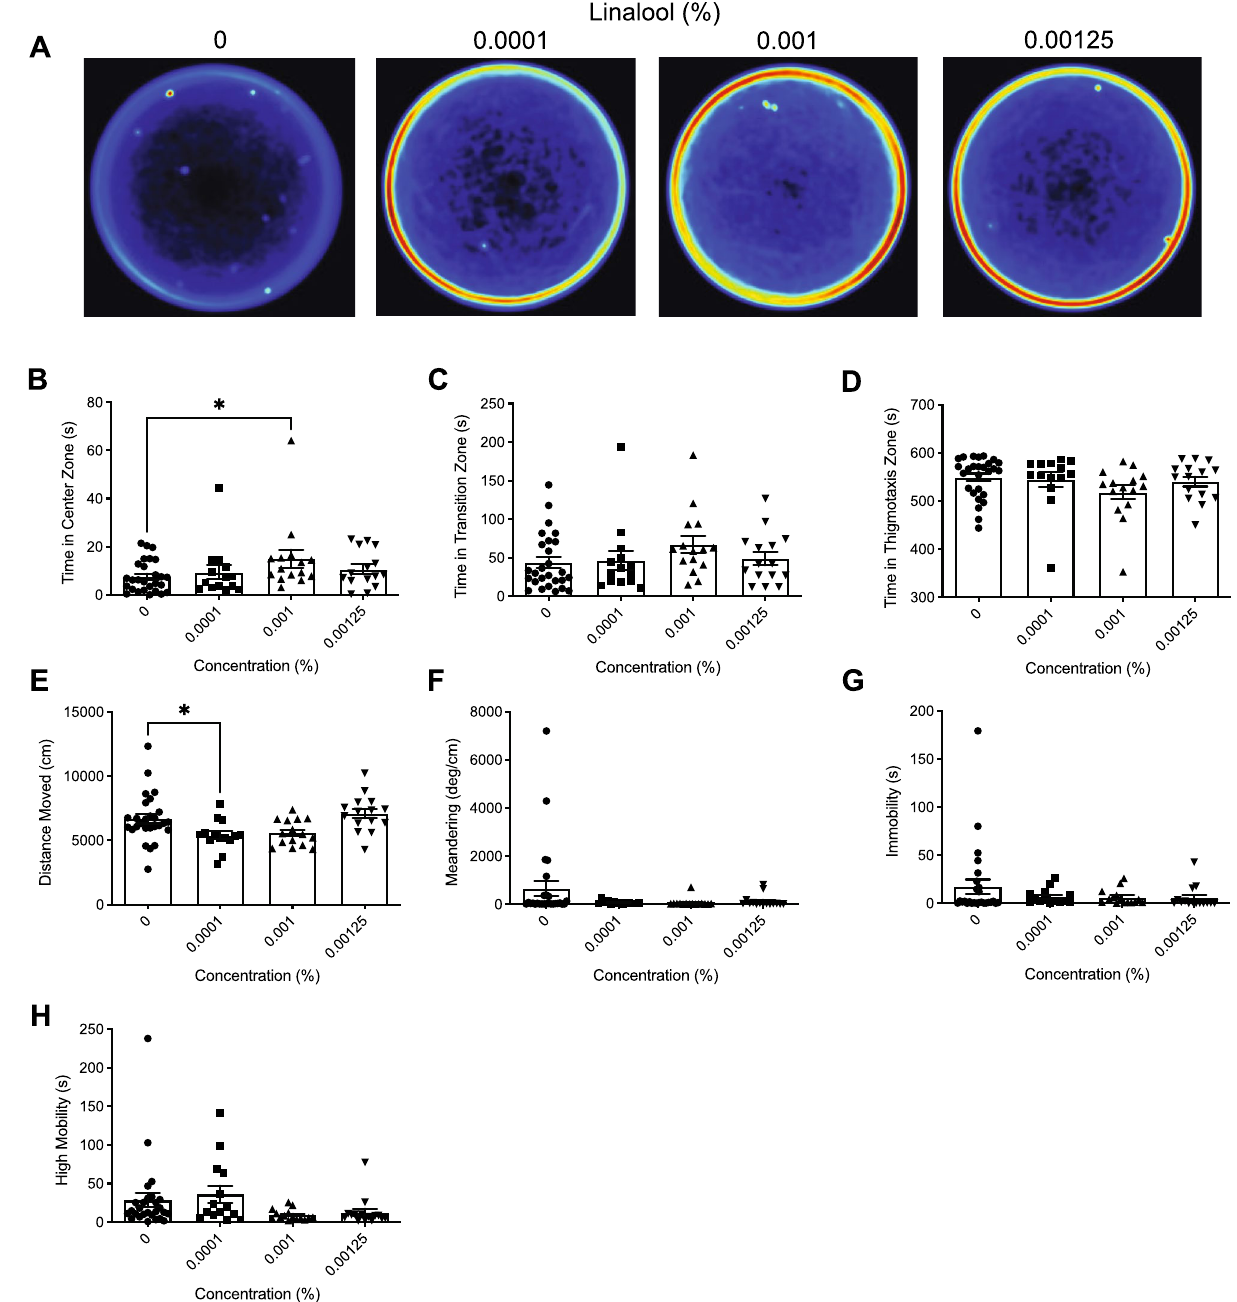
Figure 2. The effects of acute linalool administration on zebrafish behaviour assessed by the open field test. ( A ) Group heatmaps showing a coloured representation of the combined mean location of each group of fish across all trials. Average time spent in the center ( B ), transition ( C ), and thigmotaxis ( D ) zone during the open field test. Fish locomotion was quantified in the open field test by measuring distance moved ( E ), meandering ( F ), time spent immobile ( G ), and time spent highly mobile ( H ). All data are presented as mean ± S.E.M. Significant differences between controls and linalool treated groups are indicated by *( P <